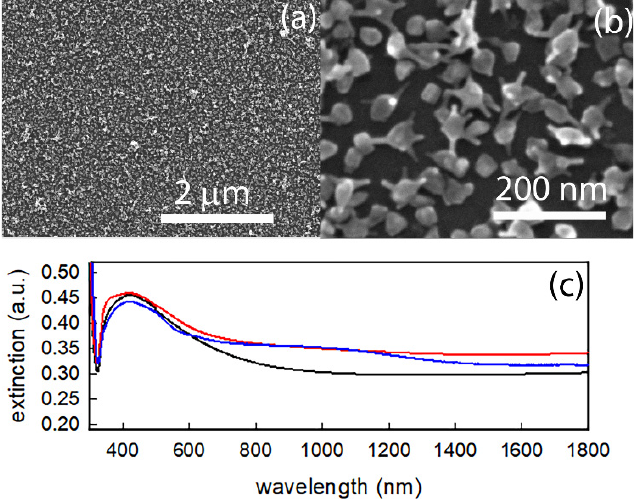
Figure 6. ( a , b ) SEM images of a GNS@Ag300 SERS chip; ( c ) spectra of three GNS@Ag300 SERS chips.